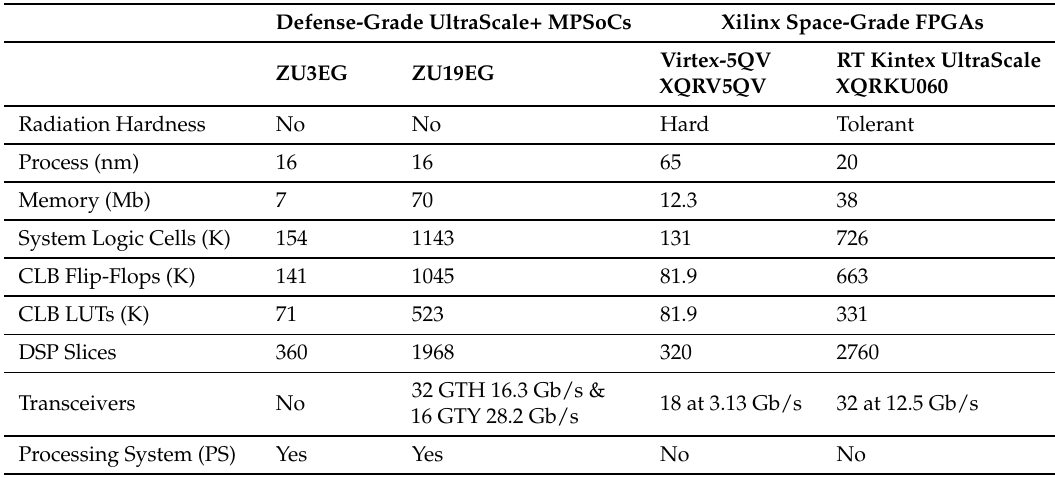
Table 6. Resource Comparison of Assorted Xilinx FPGAs and MPSoCs.